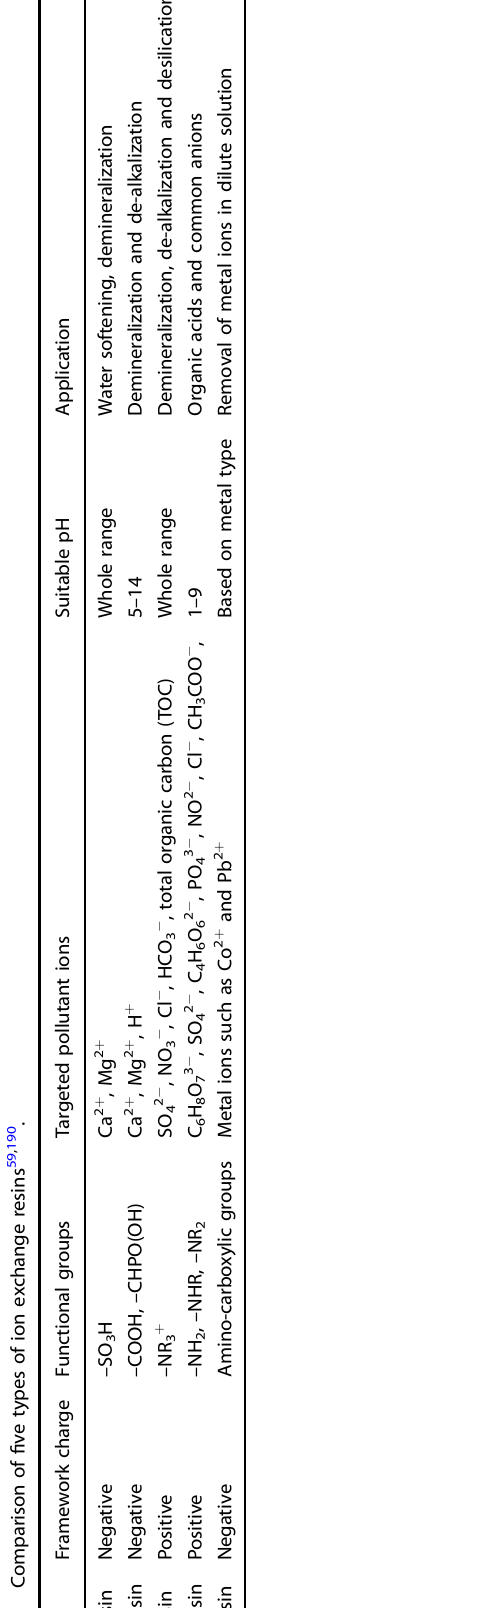
groups based on their framework (Table 6): strong-acid cation (SAC) resins, weak-acid cation (WAC) resins, strong-base anion (SBA) resins, weak-base anion (WBA) resins, and metal-selective chelating (MSC) resins 59 . Cation resins are extensively used in the water softening process, removing hardness ions (e.g., Ca 2 + , Mg 2 + , and other divalent cations). WAC resins are more effective for treating feed waters containing a high concentration of hydrogen peroxide or chlorine than SAC resin because they have a higher resistance to corrosive oxidants and are more stable. It is worth noting that different anion resins have a varied af fi nity to different acids, and WBA resins cannot remove weak acids such as carbon dioxide and silica 60 . For POU applications, IEX resins meet the needs of water softening and demineralization. An acidic environment with